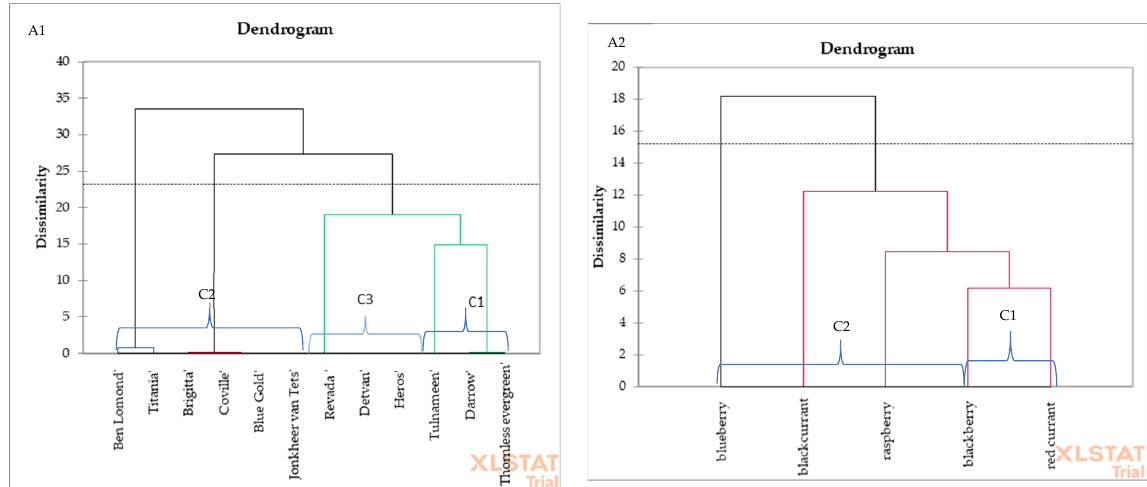
Figure 4. Cluster dendrograms for the berry fruit species ( A2 ) (raspberry ( Rubus ideus L.), blackberry ( Rubus L.), red currant ( Ribes L.), blackcurrant ( Ribes nigrum L.), highbush blueberry ( Vaccinium corymbosum L.)) or cultivars ( A1 ) (raspberry ( Rubus ideus L. Tulnameen cv.), blackberry ( Rubus L. Darrow and Thornless Evergreen cv.), red currant ( Ribes L. Detvan, Rovada, Heros, and Jonkheer van Tets cv.), blackcurrant ( Ribes nigrum L. Ben Lomond and Titania cv.), highbush blueberry ( Vaccinium corymbosum L., Coville, Blue Gold, and Brigitta cv.)).